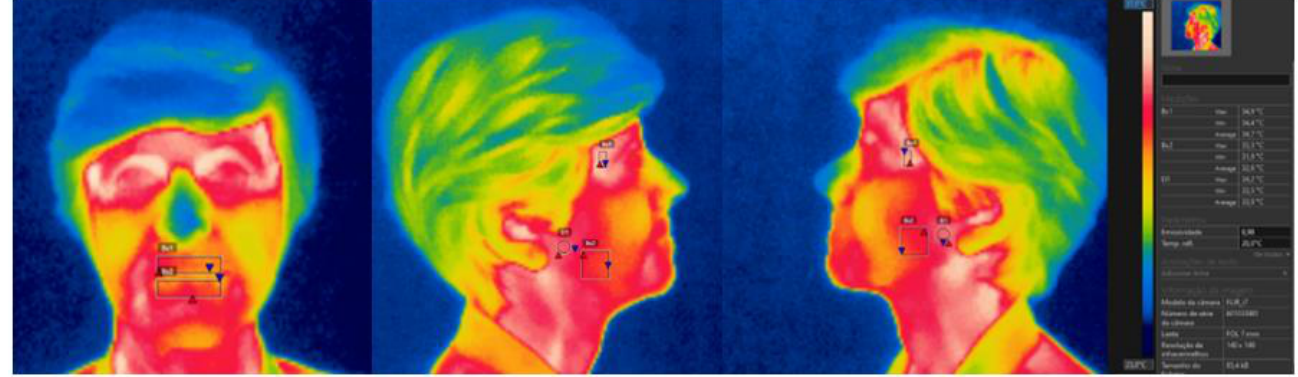
Figure 4. Frontal, right lateral, and left lateral views of the thermograms analyzed with the Flir Tools ®